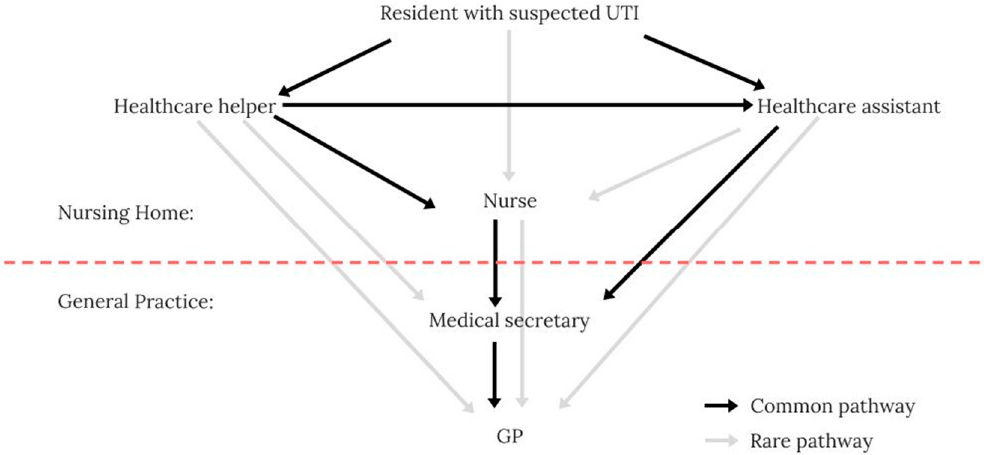
Figure 1. The typical telephone communication pathway between the nursing home and general